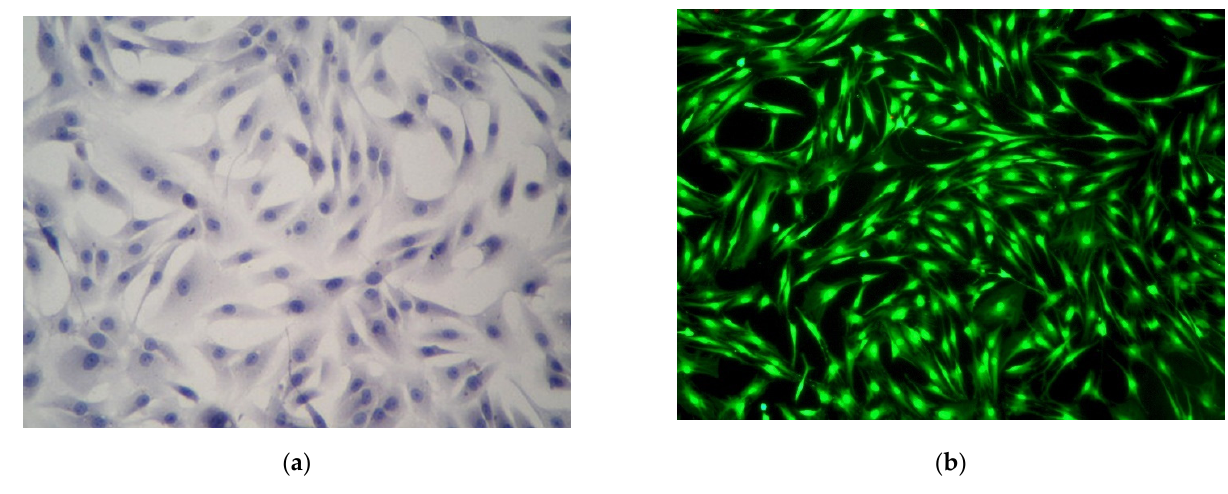
Figure 6. Human juvenile chondroblast culture: ( a ) hematoxylin and eosin staining. Light microscopy, ×100; ( b ) live chondroblasts exhibiting bright green glow. Fluorescence microscopy. Staining with Live/Dead ® fluorophores, ×100.